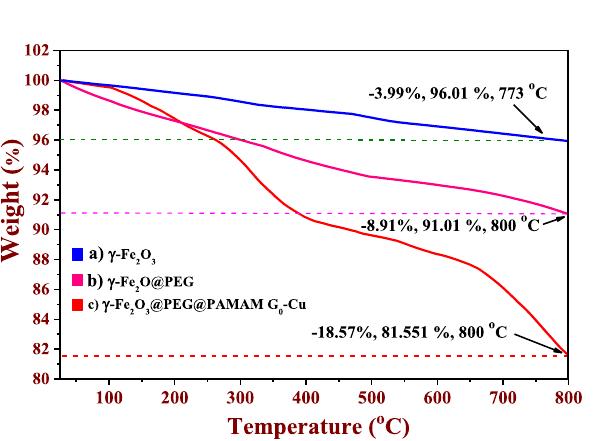
Figure 10. TGA/DTG/DTA weight loss curves of the γ-Fe 2 O 3 @PEG@PAMAM G 0 -Cu.